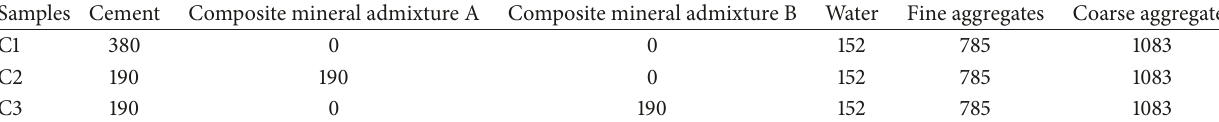
Table 3: Mixing proportions for the concrete (kg/m 3